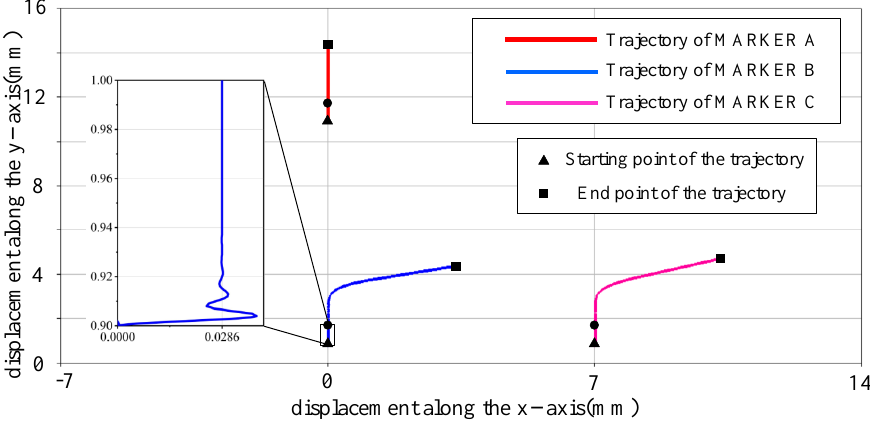
Figure 10. Motion trajectory of typical points A, B, and C on control pin mechanism.